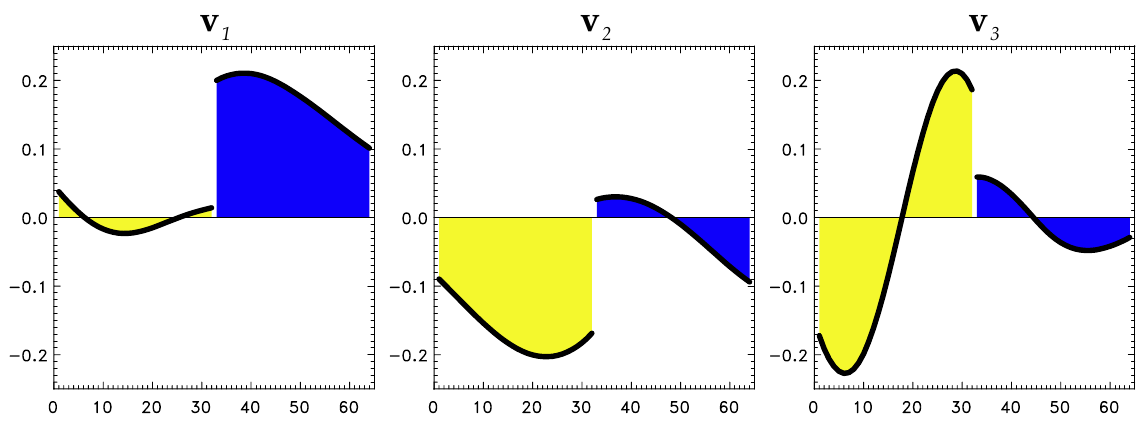
Fig. 8. The first three principal components of vB S − AL covariance matrix computed with M I = M O = 32. The input ( vB S ) portion of vector is shown in yellow, while the output ( AL ) part is indicated by the blue